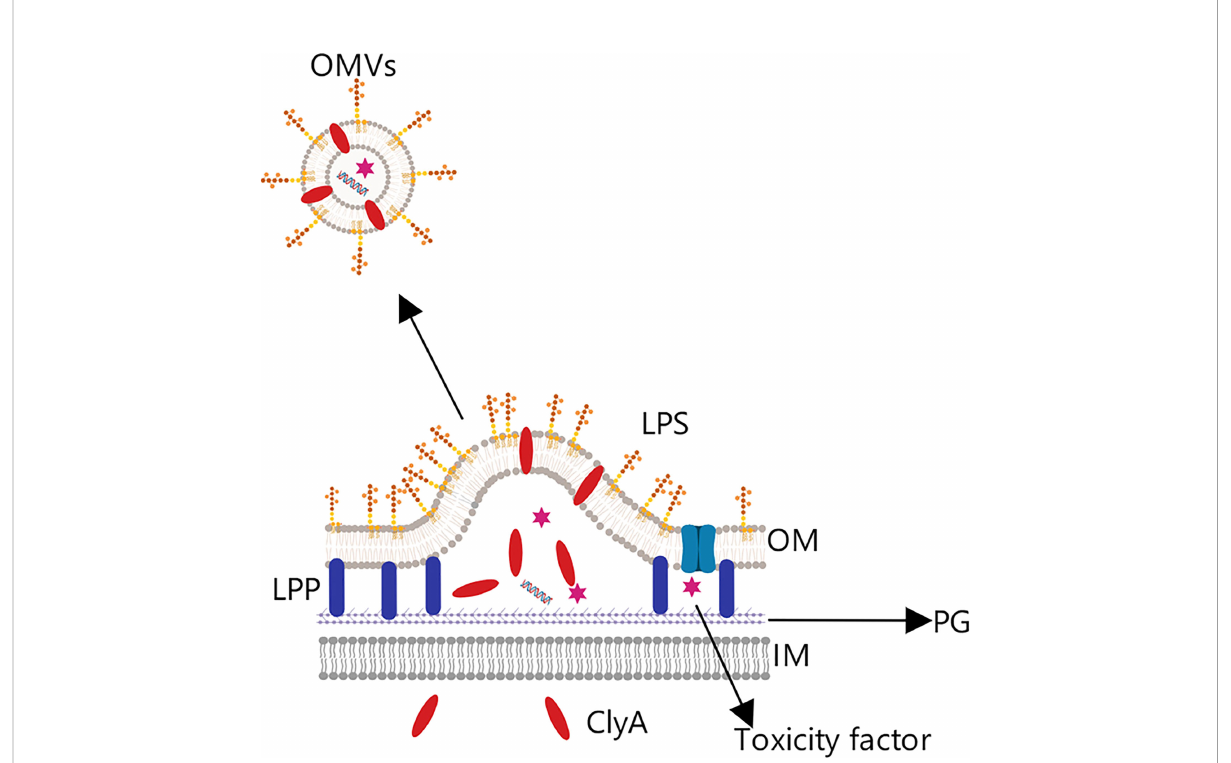
FIGURE 7 OMV tumor vaccine based on the Cytolysin A protein. Cytolysin A (ClyA) can enter the periplasmic space from the intracellular, where it then binds to the outer membrane phospholipid bilayer due to its hydrophobic structure. This characteristic was exploited by combining the C- terminus of ClyA with a speci fi c antigen to construct a chimeric protein expressed on the OMV surface, from which was prepared the corresponding tumor